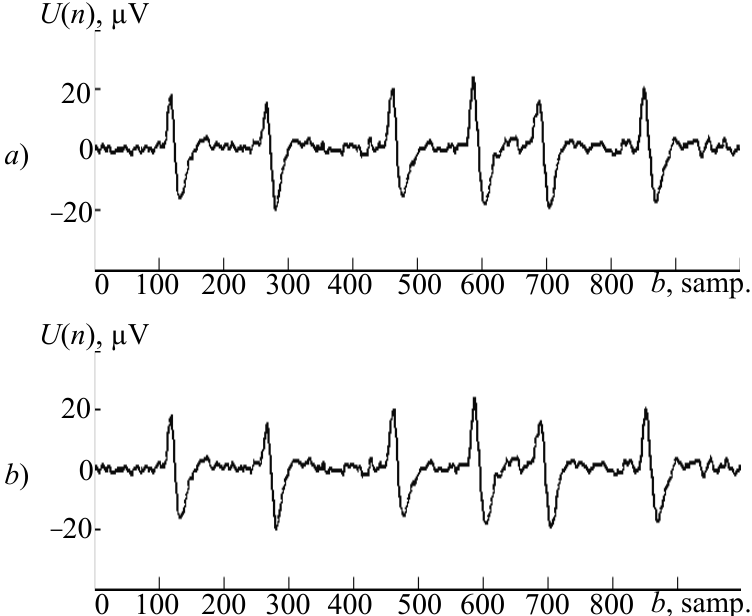
Figure 5. Results of the inverse continuous wavelet transform: ( a ) original and ( b ) restored signals.